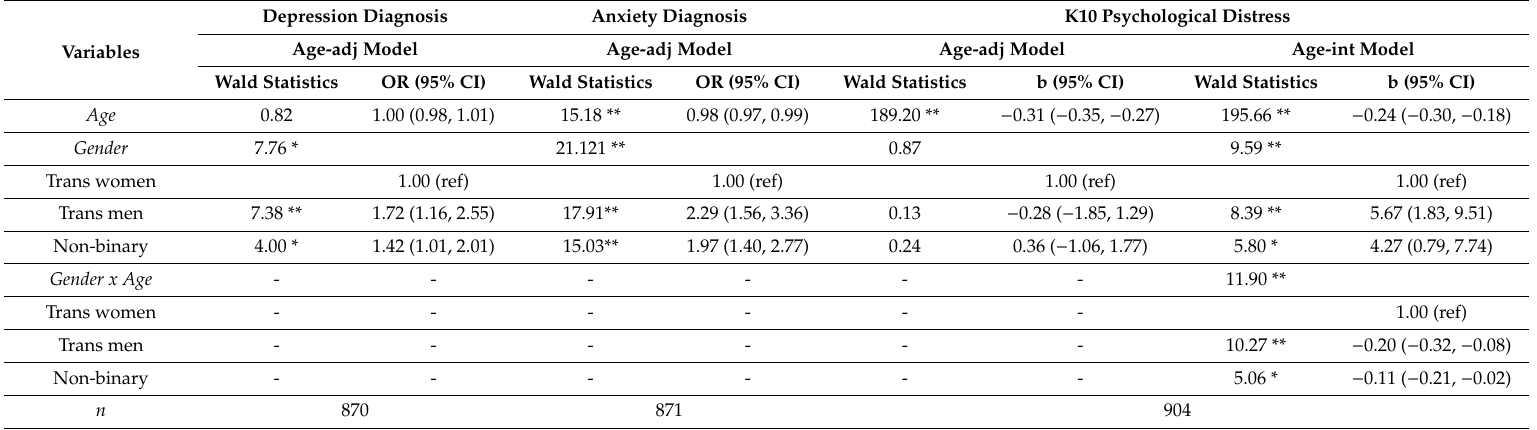
Table 2. Regression analyses of gender and age on mental health variables among Counting Ourselves age 14 +